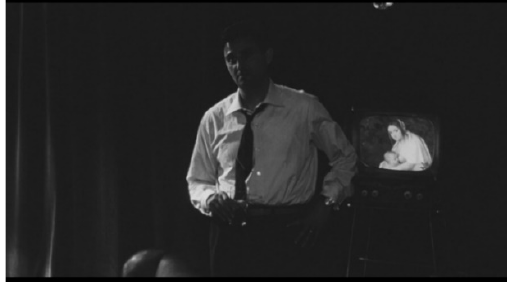
Figure 16 Screenshot from Rocco and His Brothers. (Goffredo Lombardo.)